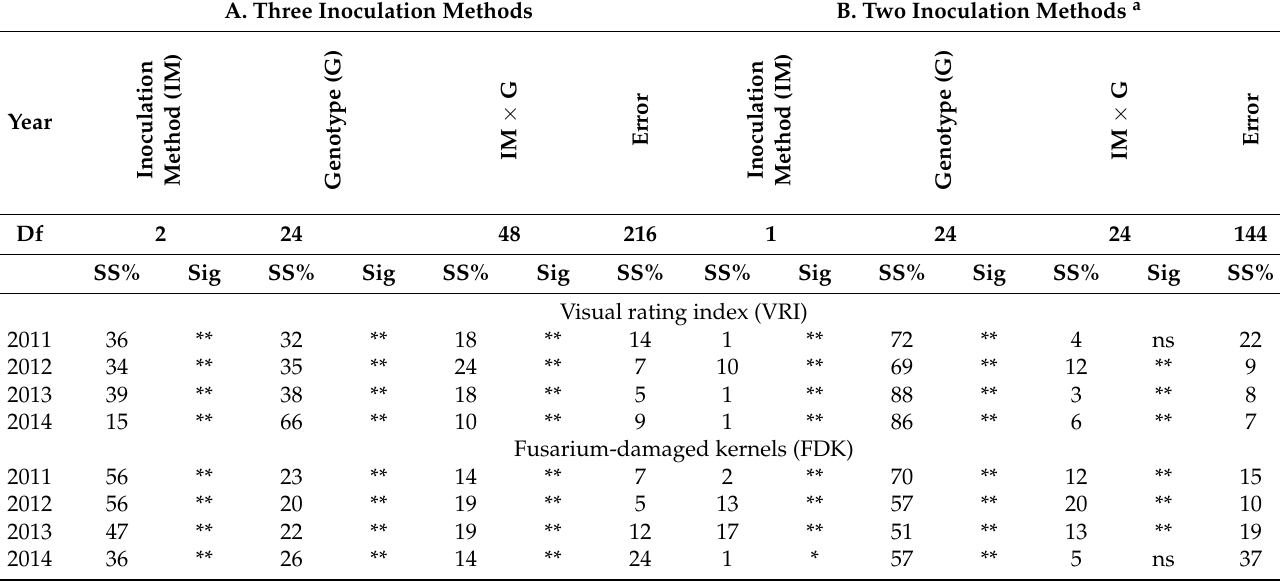
Table 1. Analysis of variance for the visual rating index and Fusarium-damaged kernels in four years across 25 genotypes and three inoculation methods ( A ) and two inoculation methods ( B ).